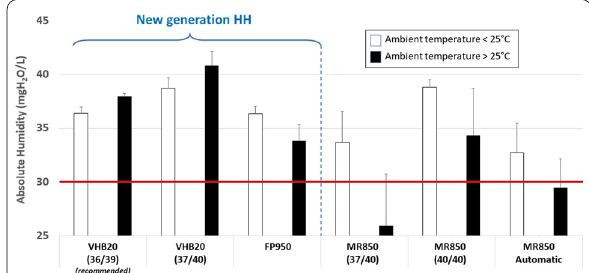
Figure: Absolute Humidity at different ambient temperatures (above and below 25 °C) delivered by new generation heated humidifiers (VHB20 and FP950) and previous generation (MR 850 at different set- tings: 37/40, 40/40 and with compensation activated). The minimum recommended absolute humidity (30 mgH2O/L) is represented by a red